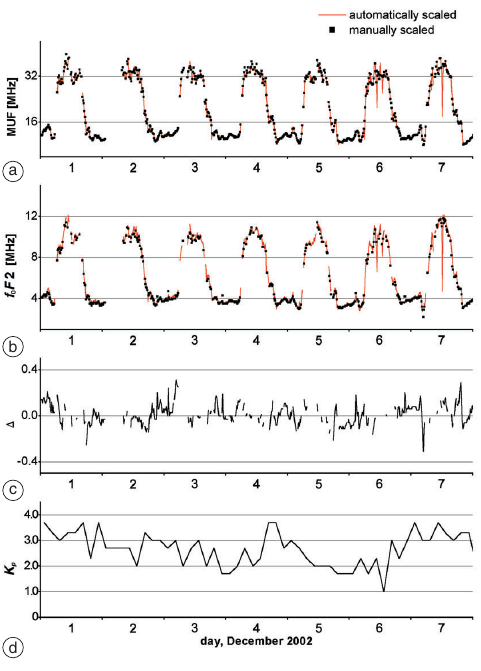
Fig. 4a-d. With reference to the days from 1 to 7 De- cember 2002: a) comparison between MUF(3000) F 2 manually scaled (black square) and automatically scaled data (red line); b) comparison between f 0 F 2 manually scaled (black square) and automatically scaled data (red line); c) plot of ∆= ( f 0 F 2 measured + − f 0 F 2 median )/ f 0 F 2 measured , used as an index of the ionospheric disturbance; d) plot of the geomagnetic activity index Kp .